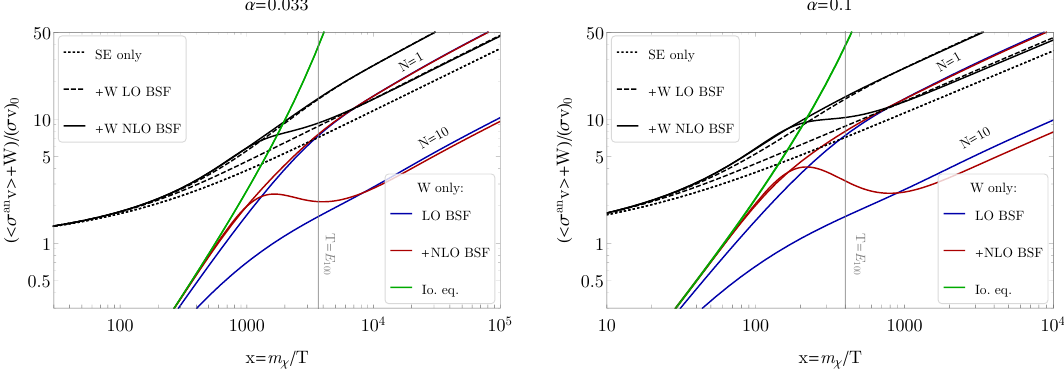
Figure 7 . Importance of NLO BSF processes for di(cid:11)erent N . Upper (lower) solid and dashed black line, as well as upper (lower) red and blue line correspond to the N = 1 ( N = 10) case. All quantities are normalized to ( (cid:27)v ) 0 (cid:17) (1 + N ) (cid:25)(cid:11) 2 =m 2 , such that the curve for SE annihilation and (cid:31) for W in ionization equilibrium are independent of N